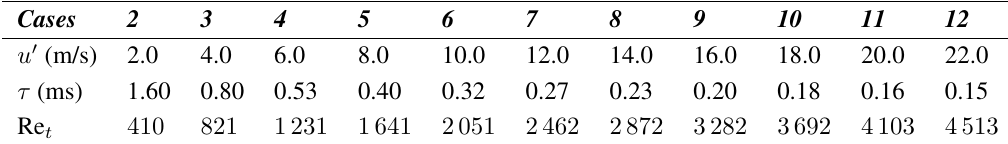
Table 2. Initial turbulence